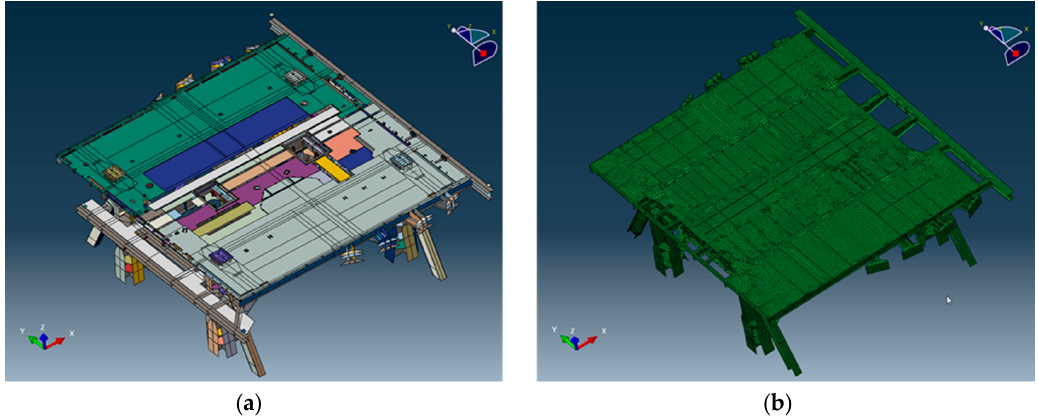
Figure 16. ( a ) Geometry model and ( b ) finite element model of drill floor.